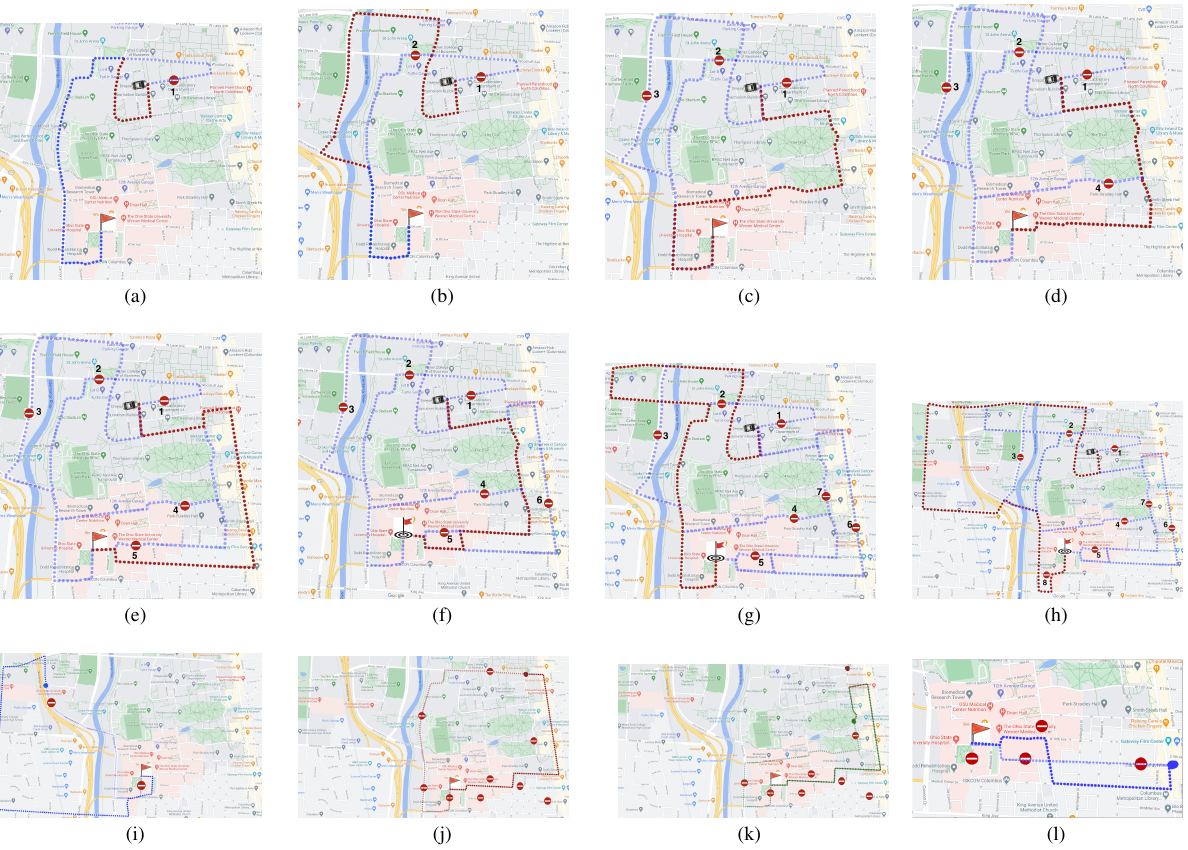
Figure 9. Agent’s dynamic routing plan regarding to the change of the map